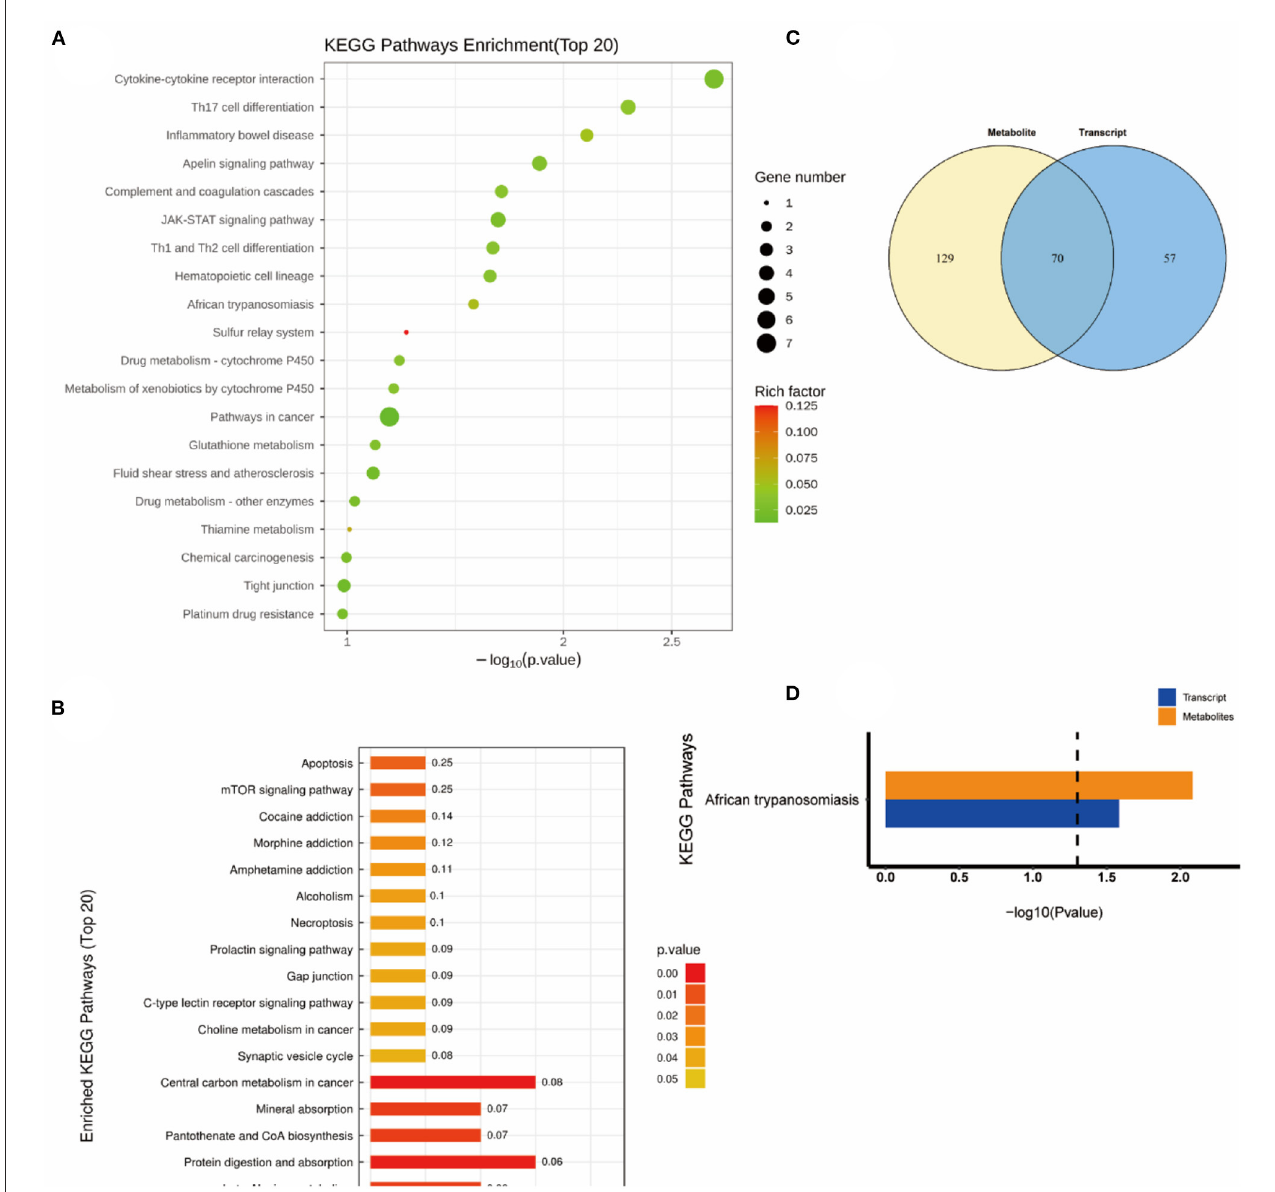
FIGURE7 KEGG pathway analyses of DEGs and DMs identified by comparing the NEMP group and the control group. (A) KEGG pathway analyses of DEGs. (B) KEGG pathway analyses of DMs. (C) Venn diagram of the KEGG pathway involving DEGs and DMs. (D) Enrichment analysis of KEGG pathway between DEGs and DMs. N =